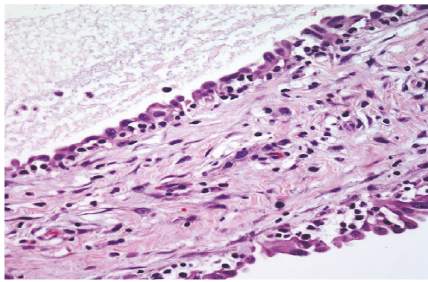
Figure 1: H&E-Low power magnification showing soft tissue with numerous variably sized cystic spaces.